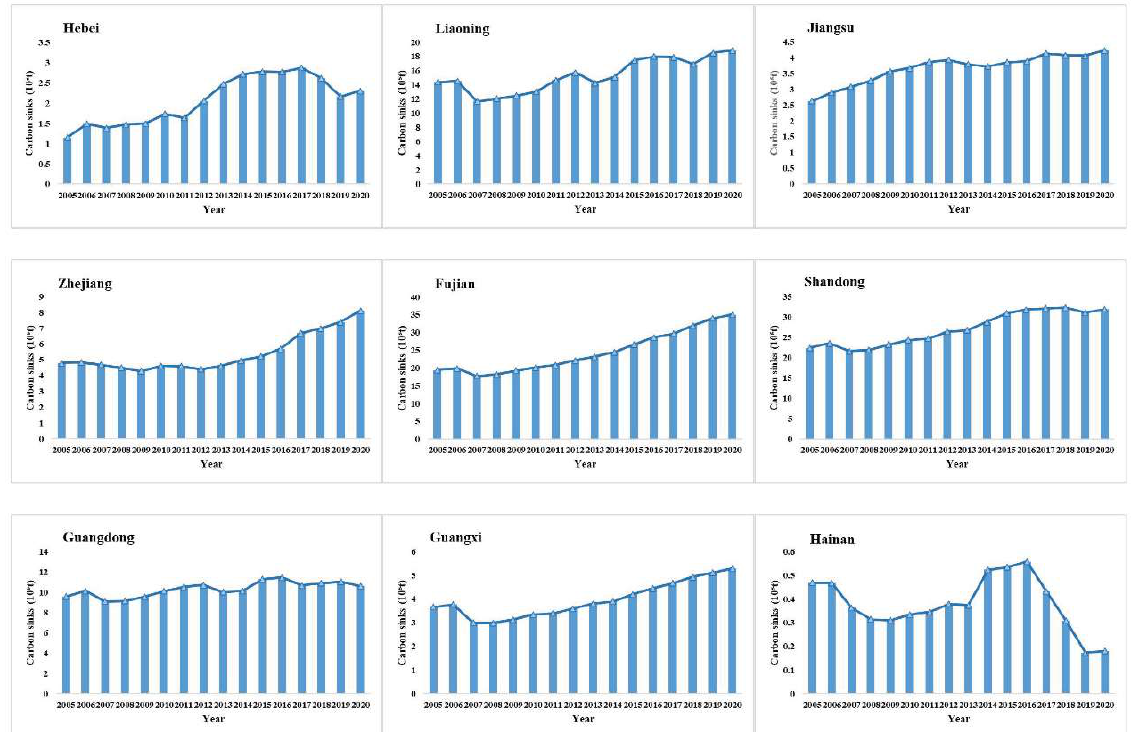
Figure 3. Changes in carbon sinks in coastal provinces from 2005 to 2020.